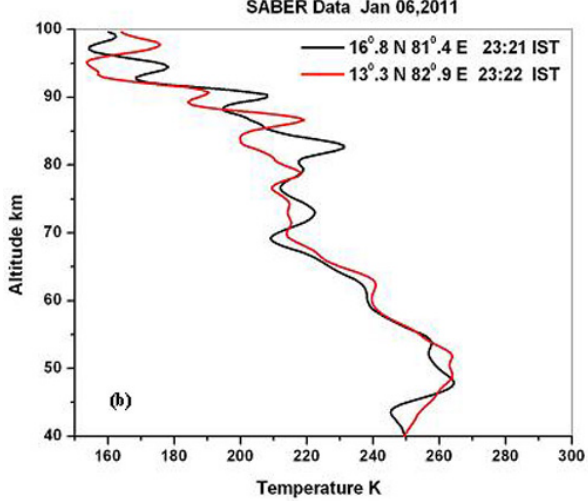
Fig. 1a. Rayleigh lidar temperature profiles and associated standard deviations deduced with the help of CIRA-86 model temperatures (solid black lines with purple standard deviations) and O 2 airglow temperatures (dark blue lines with yellow standard deviations) for the backscatter data of 6 January 2011. Shown in red lines are the SABER estimates for a grid of 9–19 ◦ N and 74–84 ◦ E for instanta- neous comparison.